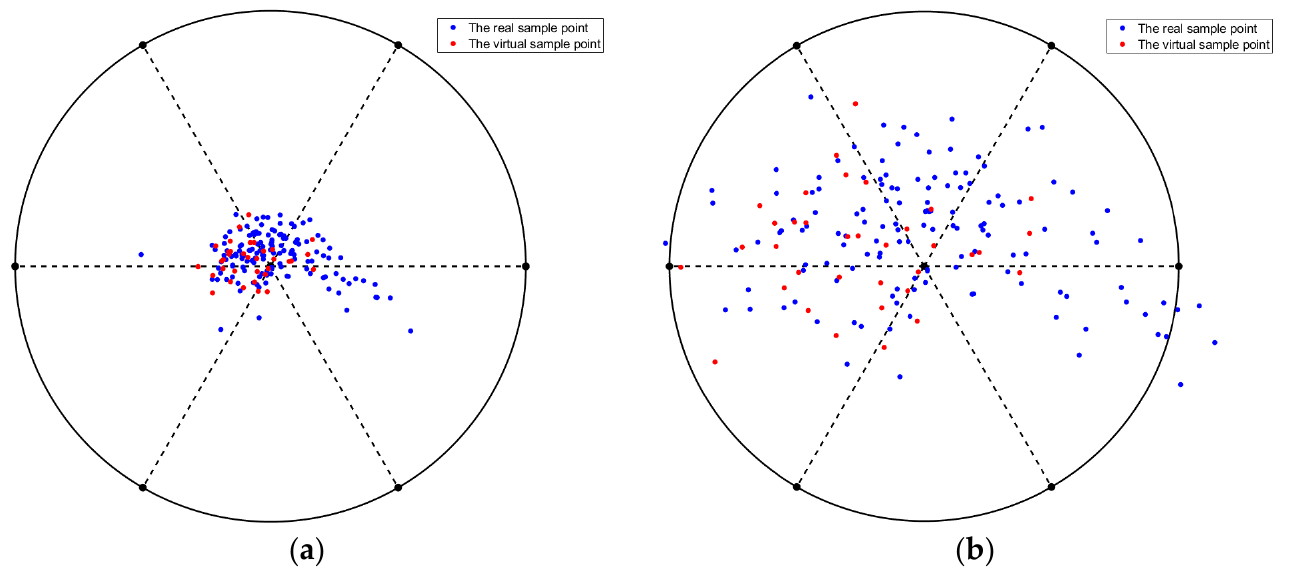
Figure 7. Visualization of virtual sample data distribution generated by GAN network: ( a ) radial visualization, ( b ) star coordinate visualization.